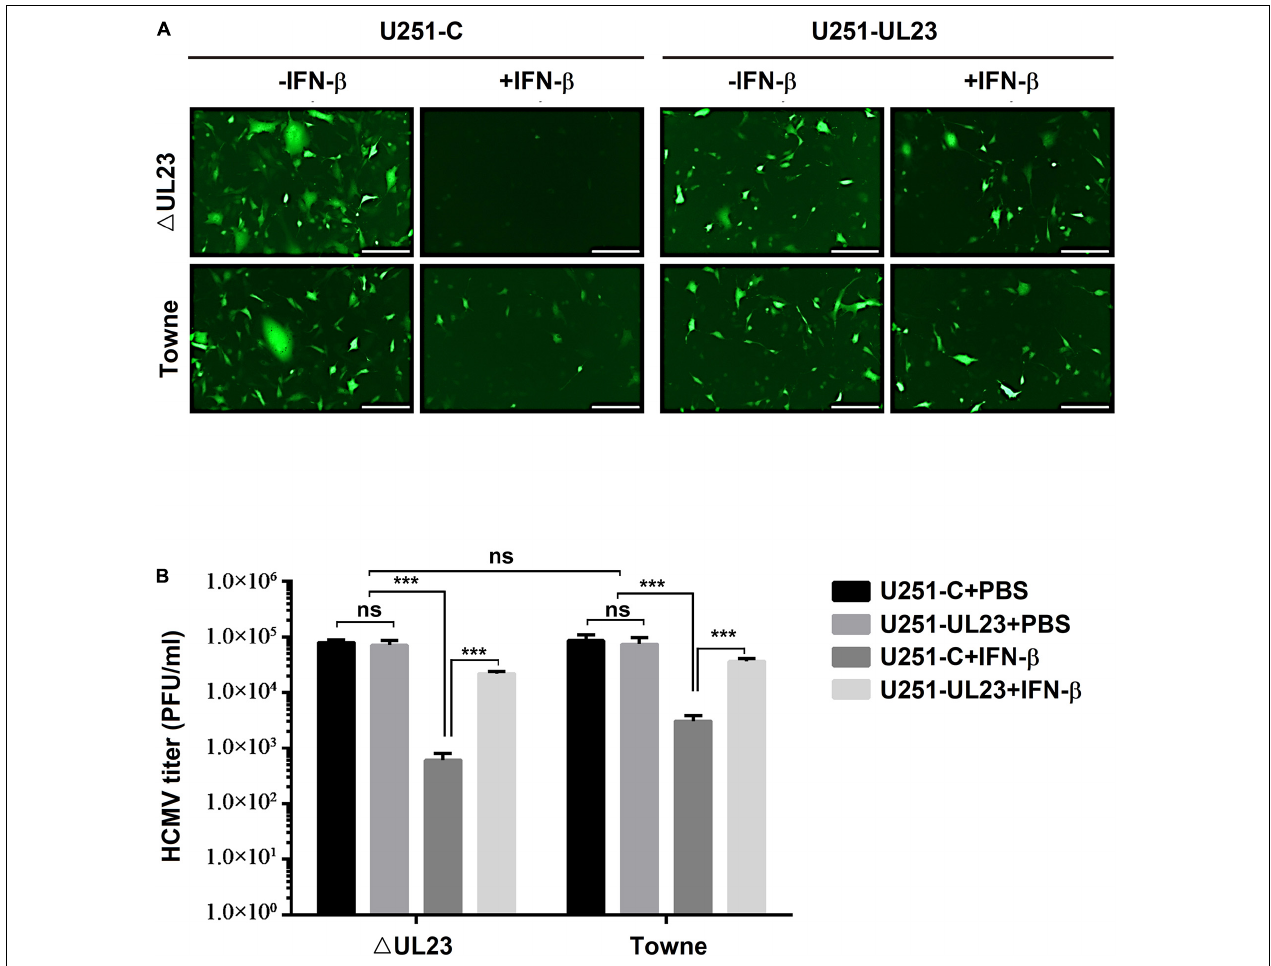
FIGURE 1 | Human cytomegalovirus (HCMV) UL23 confers resistance to type I IFN upon viral infection. (A) UL23 stably expressed U251 cells (U251-UL23) and control cells (U251-C) were treated with or without 100 U/ml IFN- β for a period of 2 h and then infected with HCMV or HCMV– (cid:49) UL23 (MOI = 1) for 72 h before fluorescence microscopy. Scale bars, 200 µ m. (B) After infection for 5 days, we harvested the total infected cell cultures, followed by determination of viral titers. Each assay was conducted thrice. Data are shown as mean ± SD. * p < 0 . 05, ** p < 0 . 01, *** p < 0 . 001 (unpaired, two-tailed Student’s t -test). Data are representative of three independent experiments with similar